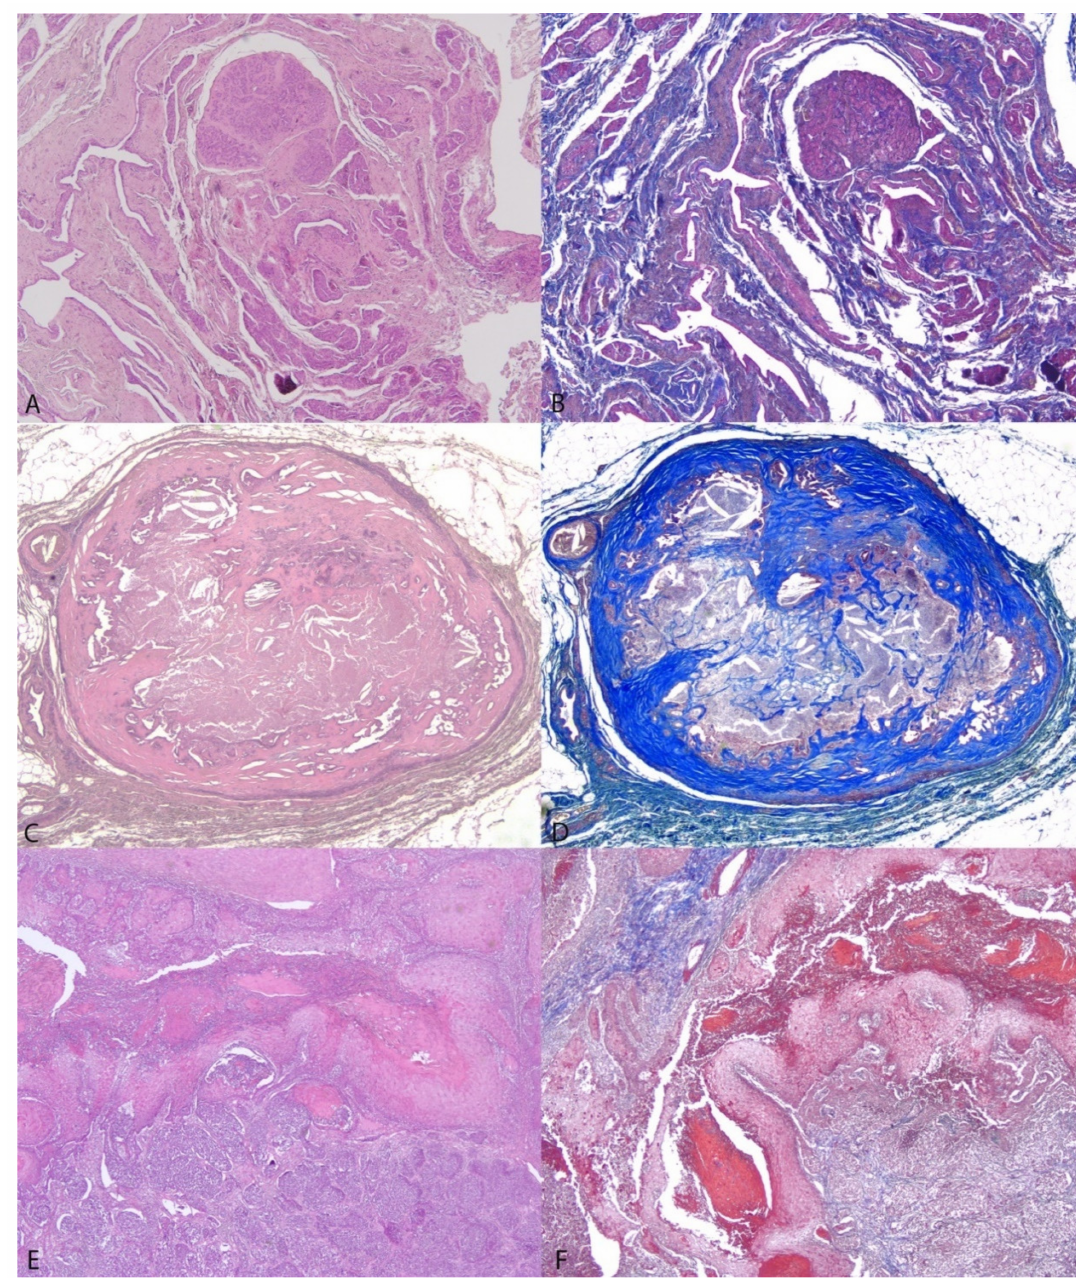
Figure 4. Fibrosis levels in benign and malignant canine mammary lesions. Figures (50 × ) show lobular hyperplasia with fibrosis ( A , B : sample No. 8b), a sclerosing simple adenoma ( C , D : sample No. 12b), and an adenosquamous carcinoma ( E , F : sample No. 7b) stained with H/E in the left column ( A , C , E ) and Masson trichrome in the right column ( B , D , F ), where collagen fibres have been stained in blue. As expected, a significantly ( p = 0.035) higher percentage of vimentin-positive cells was also observed in complex and mixed malignant tumours (37% ± 3.9%) with respect to other malignant histotypes (26.9 ±